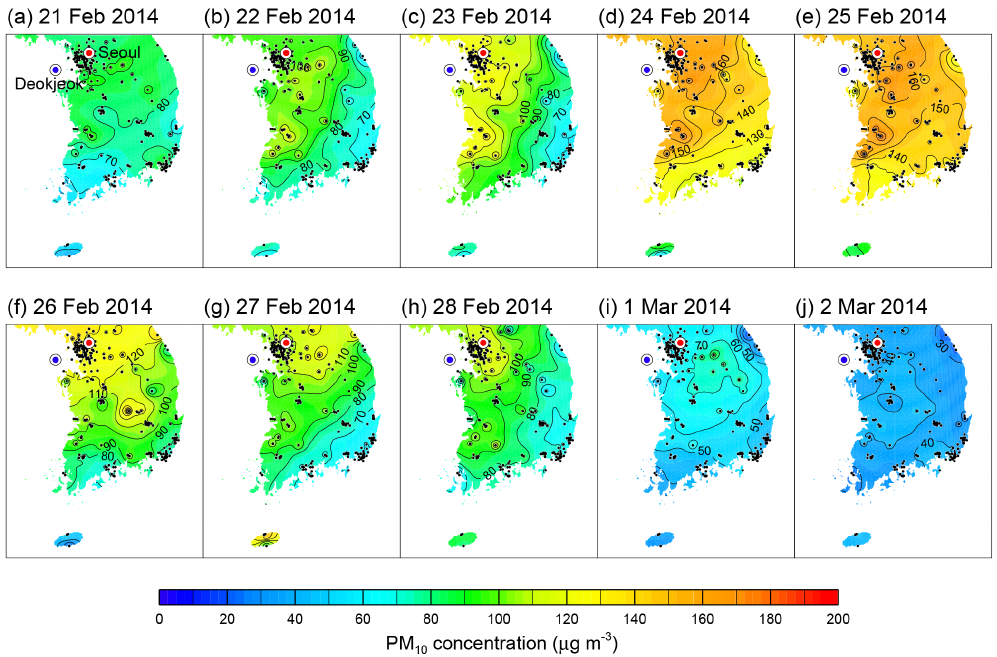
Figure 3. Spatial distribution of PM 10 concentration for the period 21 February to 2 March 2014 using data from 247 air quality monitoring sites (black dots) in South Korea.